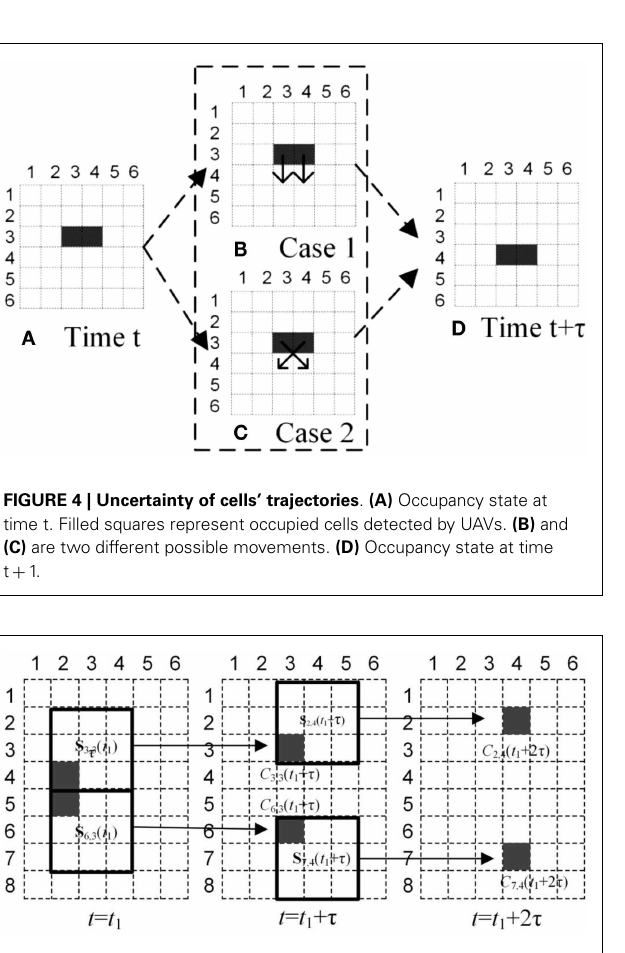
FIGURE 5 | Illustration of neighborhood states and cell occupancy . Solid squares: neighborhoods at each time stamp. Filled squares: occupied cells detected by